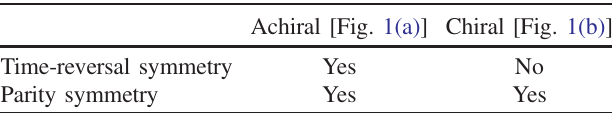
TABLE I. Presence or absence of Dirac-cone stabilizing sym- metries in the two model systems depicted in Fig. 1. Achiral [Fig. 1(a)] Chiral [Fig.